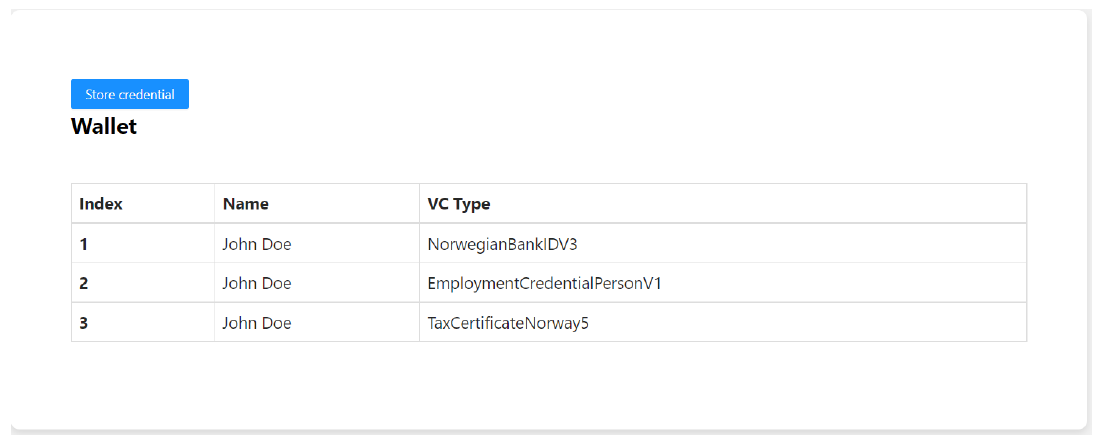
Figure 5. Holder’s web wallet and